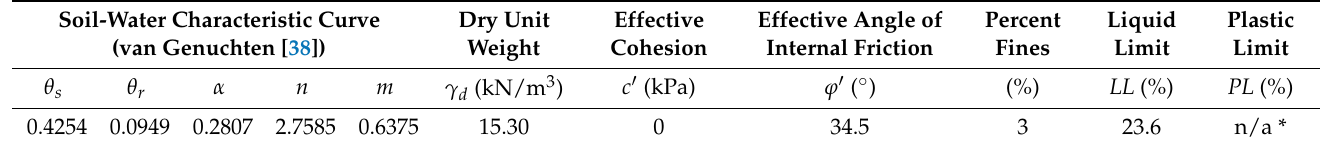
Table 5. Representative geotechnical property data of the analysis domain area. * n/a: not applicable. Soil-Water Characteristic